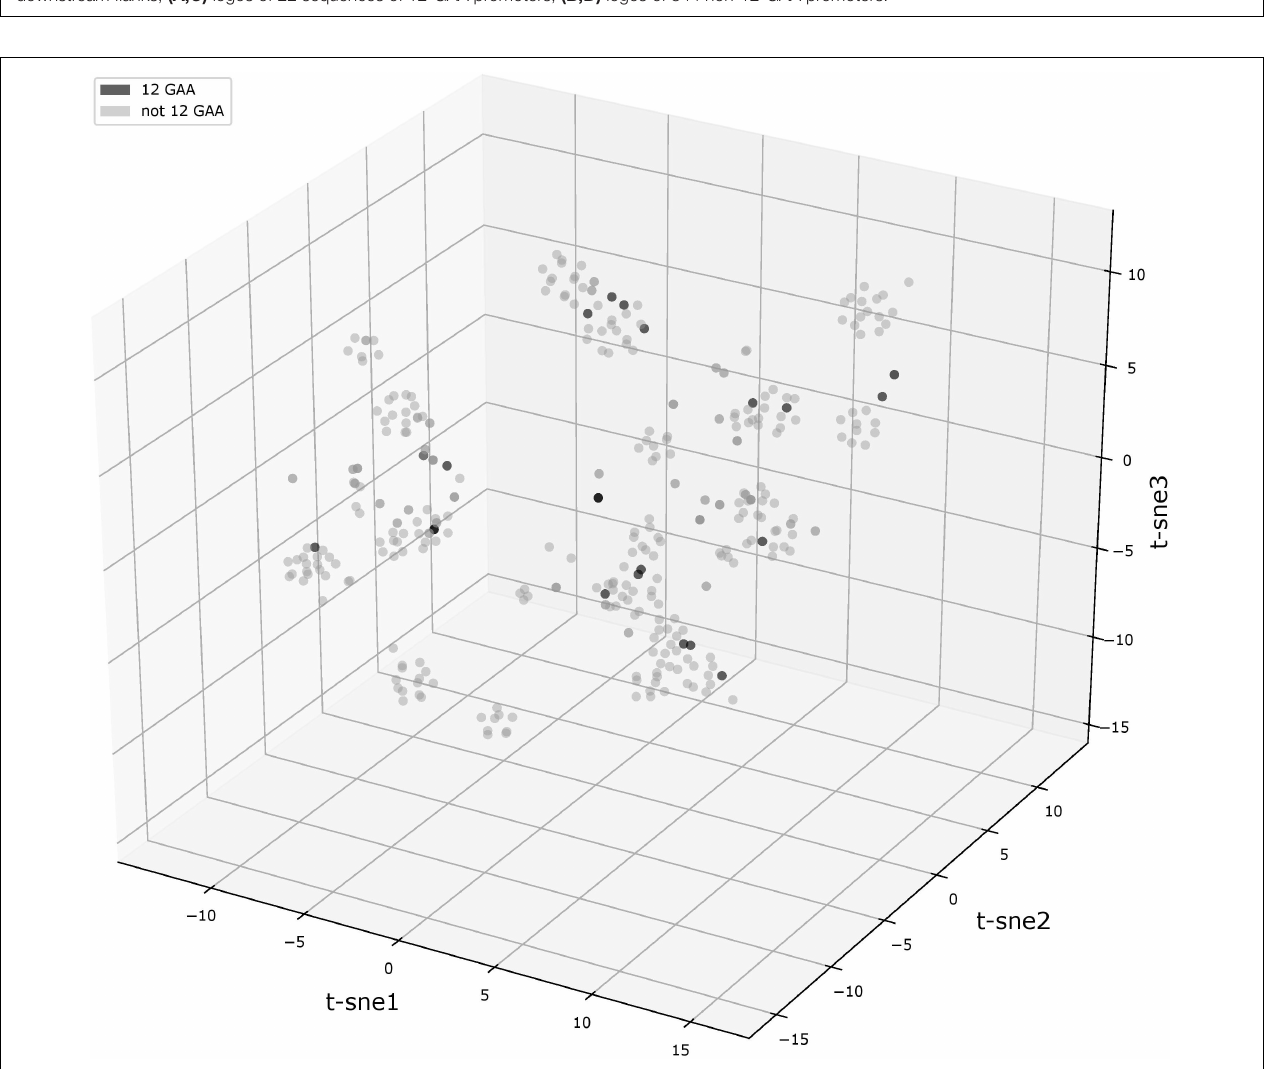
FIGURE 1 | The motif of (GAA)n flanking sequences in vlhA promoters. Logos show identity of motifs for promoters with different GAA number. Sequences 50 bp length were aligned by T-coffee program, gaps included in the alignment. Logo constructed by WebLogo 3.6.0; (A,B) logos for upstream flanks, (C,D) logos for downstream flanks; (A,C) logos of 22 sequences of 12-GAA promoters; (B,D) logos of 344 non-12-GAA promoters.